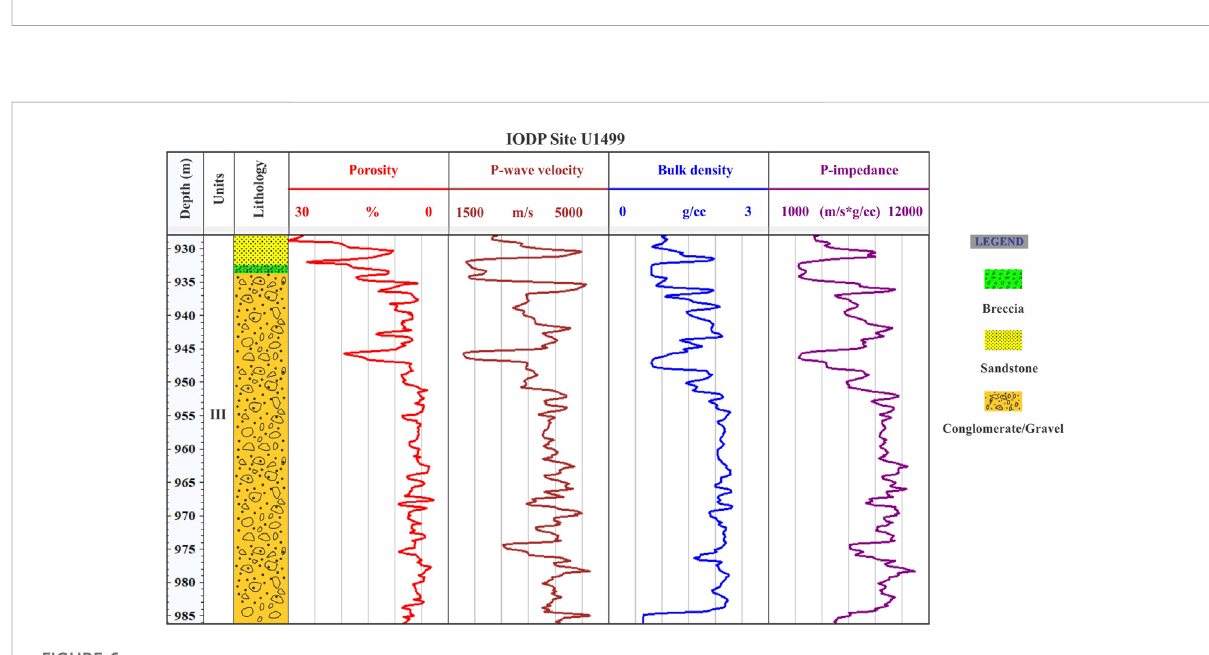
Core data results of the studied sites U1433 in the (SWSB) and U1431 in the (ESB), with measurements of moisture, density (MAD) and, P-wave velocity(PWC). (A) Data from IODP site U1433; (B) Data from IODP site